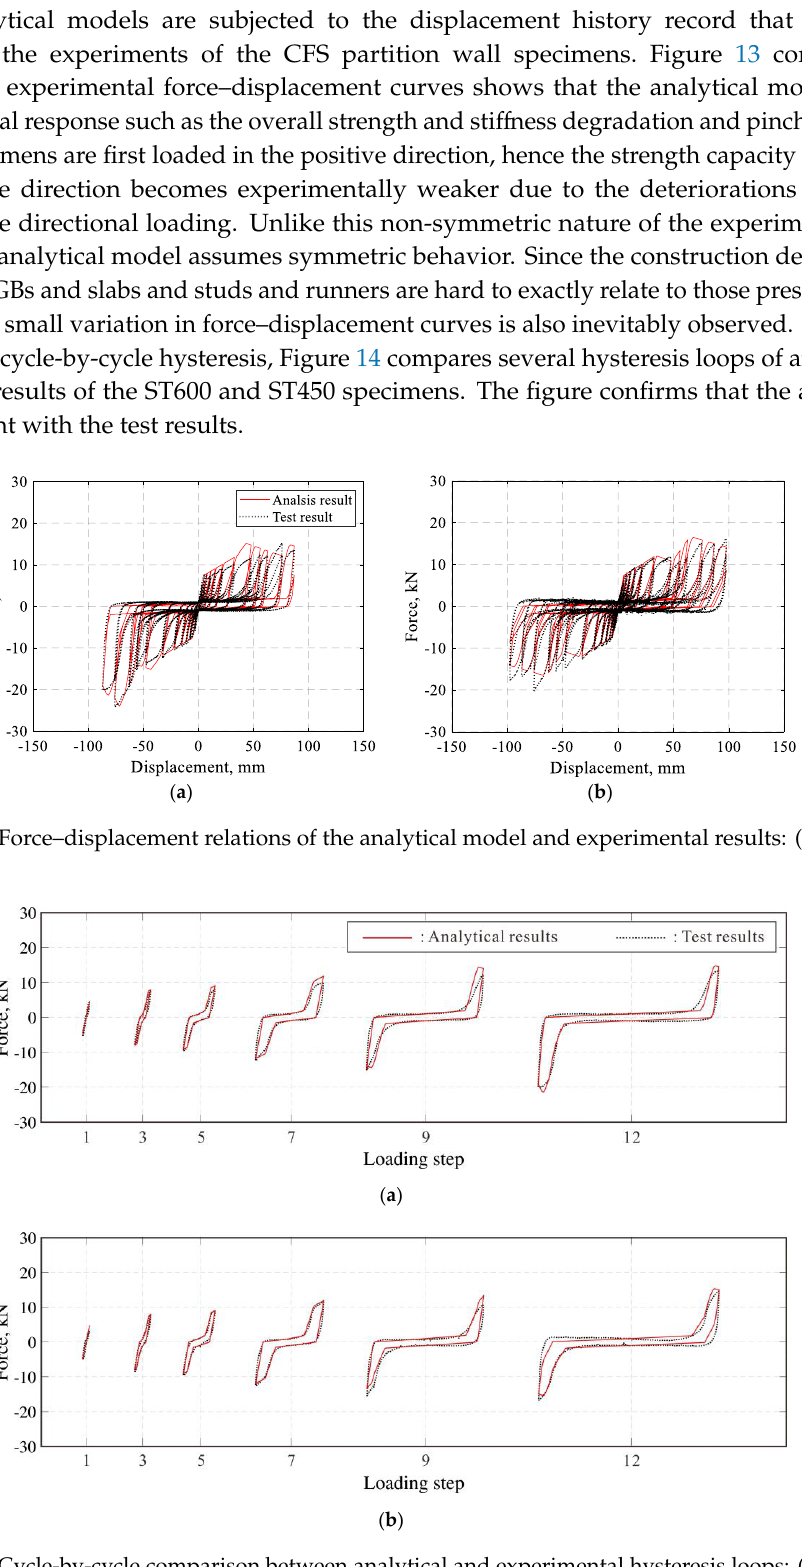
Figure 14. Cycle-by-cycle comparison between analytical and experimental hysteresis loops: ( a ) ST600; ( b ) ST450.